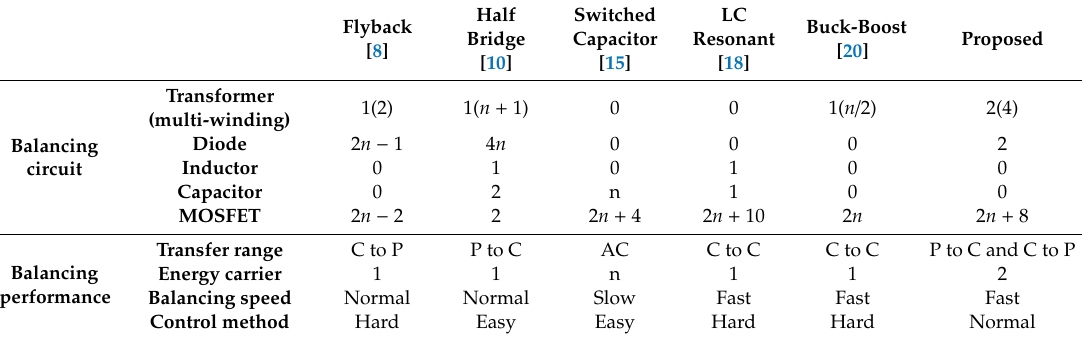
Table 2. Comparison of balancing circuits for n cells battery